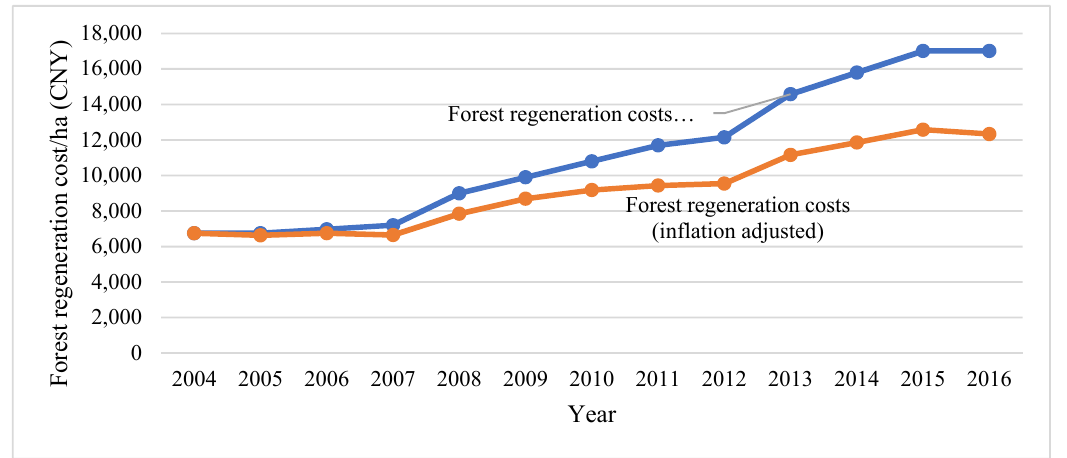
Figure 3. Increase in forest regeneration (including reforestation and tending) costs per ha. Note: Data is derived from three sources: officials from the township forest station and the county-level forest bureau, managers of FUGs, and the Forest Logging and Silvicultural Farm of Sha County. Forest regeneration costs may vary according to the specific techniques and standards adopted, and the data in this figure is the average. The inflation rate data was derived from the Statistical Yearbook of Sha County.